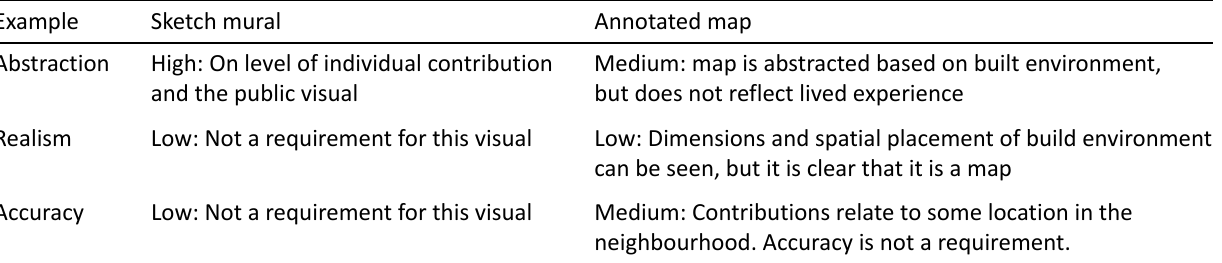
Table 2. Review of the public visual artefacts in JigsAudio and PlaceChangers using the characteristics of visualisations (see Pietsch, 2000).